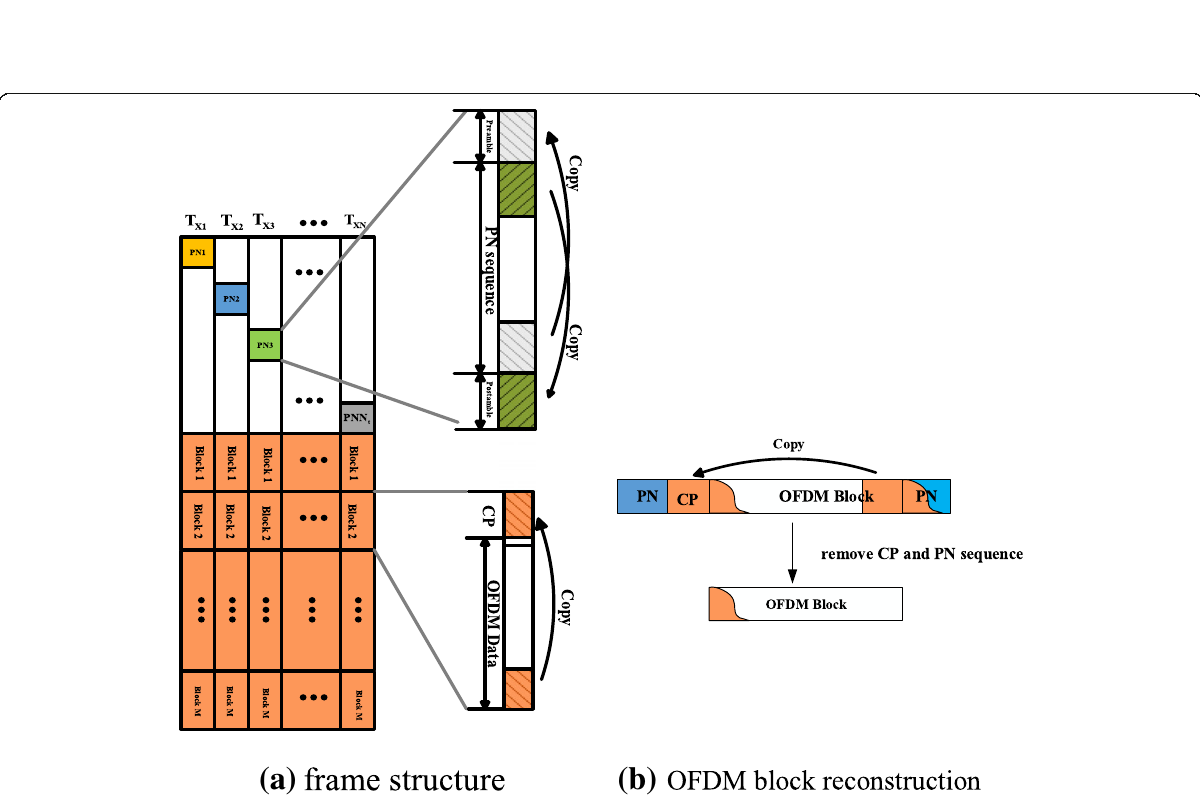
Fig. 2 The proposed OFDM frame